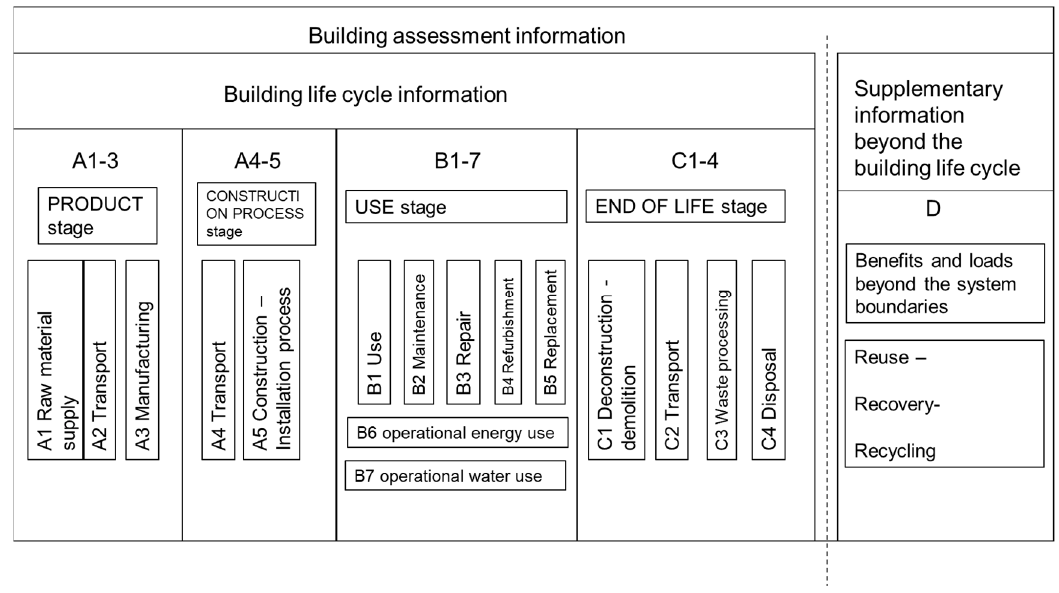
Figure 1. Environmental payback.